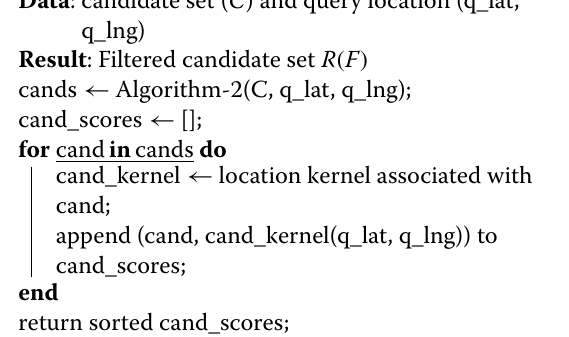
Algorithm 1: Device ID-based (age-based) filtering Data : candidate set ( C ) and query device ID (q_id)